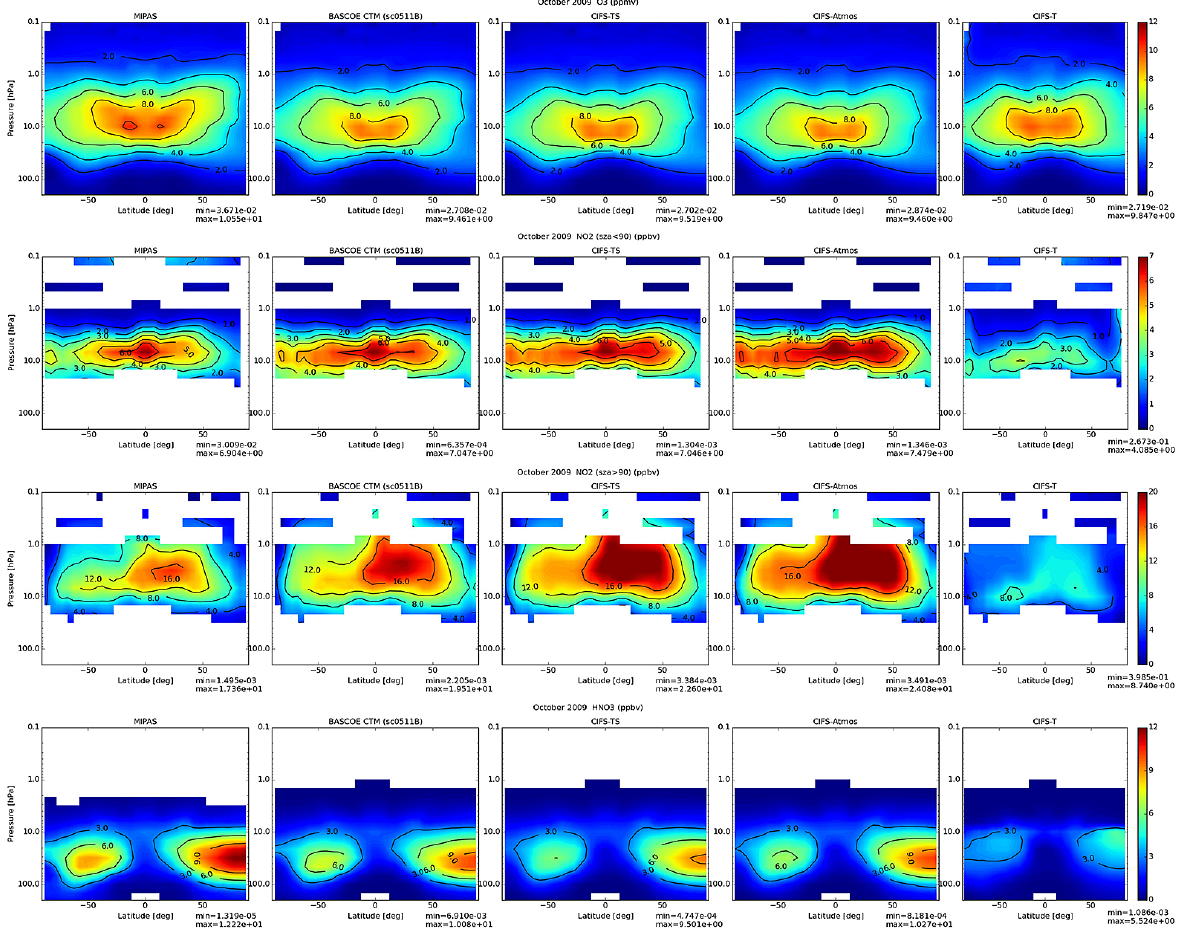
Figure 7. Zonal mean stratospheric O 3 (top row, units ppmv), daytime NO 2 (second row), night-time NO 2 (third row) and HNO 3 (bottom row, all in units ppbv) for October 2009 using MIPAS observations (first column) and co-located output of BASCOE-CTM (second), C-IFS- TS (third), C-IFS-Atmos (fourth) and C-IFS-T